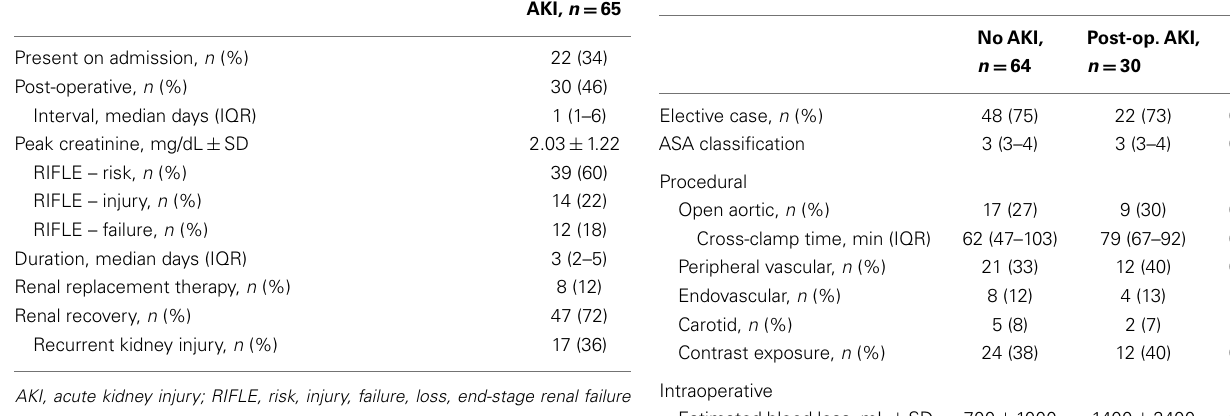
Table 2 |Acute kidney injury event characteristics . Table 3 | Procedural and intraoperative factors of patients with or without post-operativeAKI